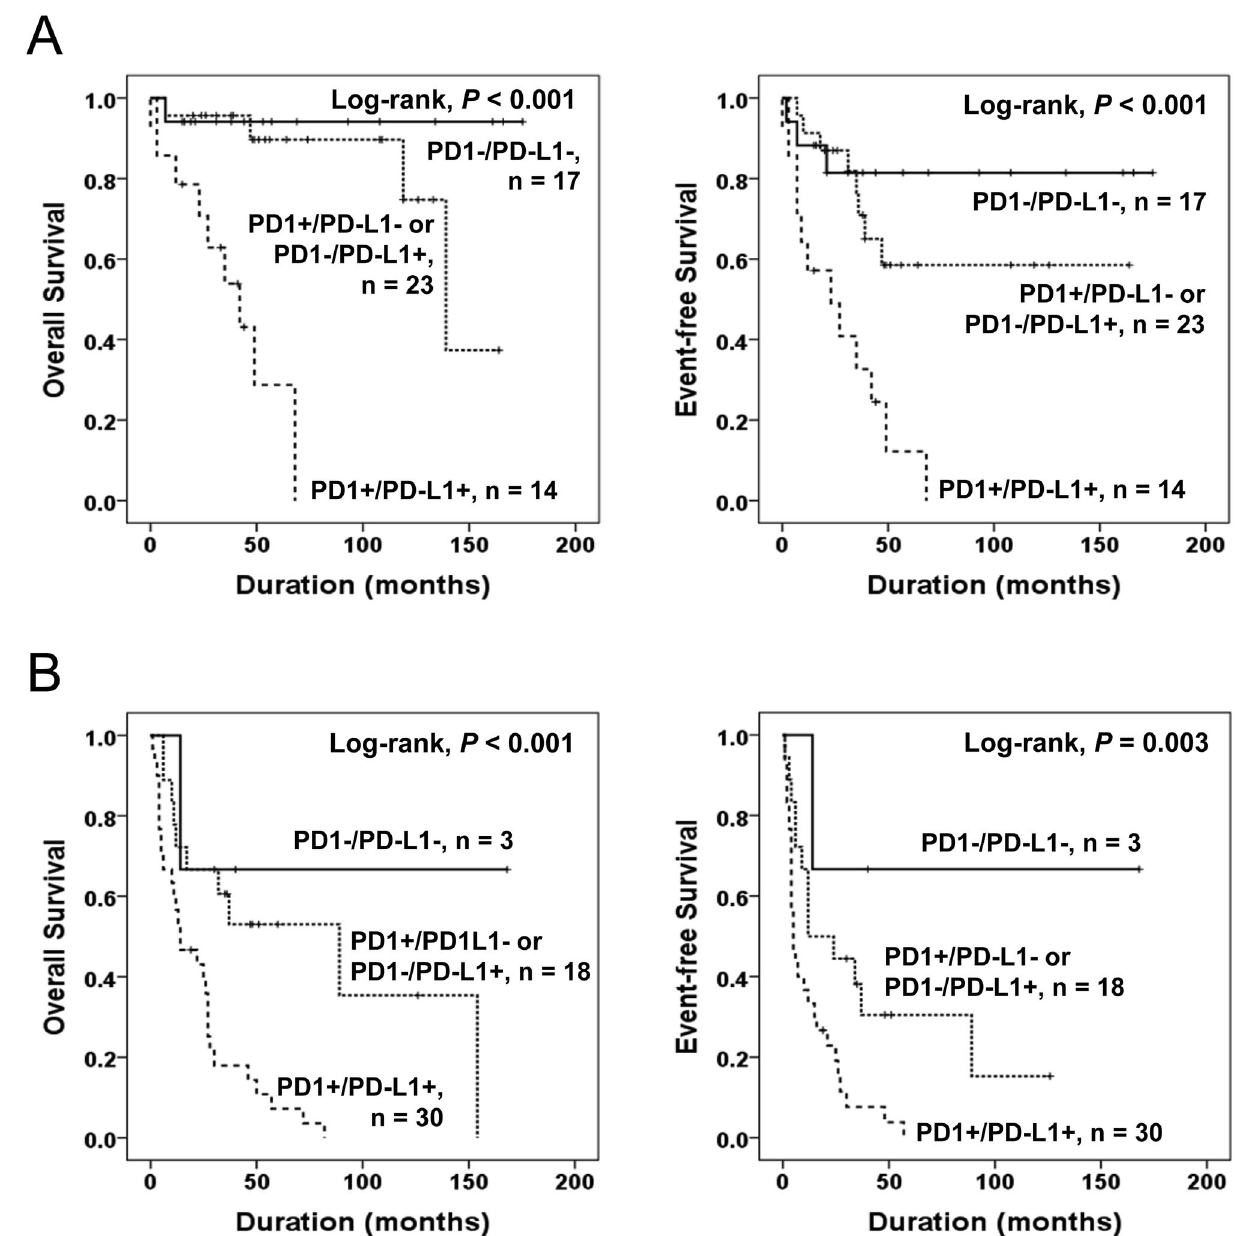
Figure 3. Kaplan-Meier survival analysis in the low and high stage subgroup of soft-tissue sarcomas. Overall survival and event-free survival according to the combined expression pattern of PD1 and PD-L1 (PD1/PD-L1) in low stage (stage I and II) (A) and high stage (stage III and IV) (B) subgroup of soft-tissue